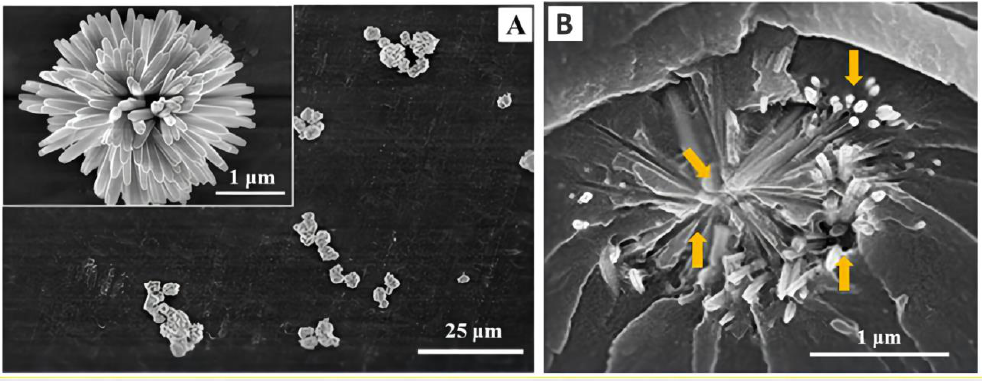
Figure 8. SEM micrographs of ( A ) UHA fillers and ( B ) the fracture surface of the dental resin with 20 wt%UHA. Images from [53].